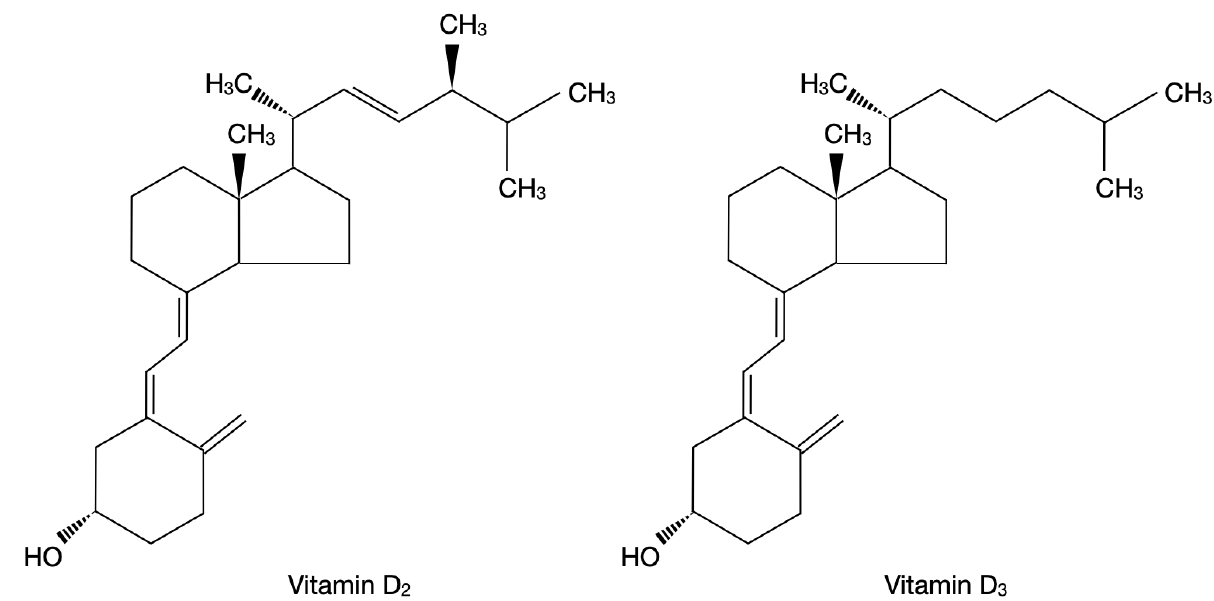
Figure 1. Chemical structure of vitamin D 2 and vitamin D 3 on the basis of the literature [27].